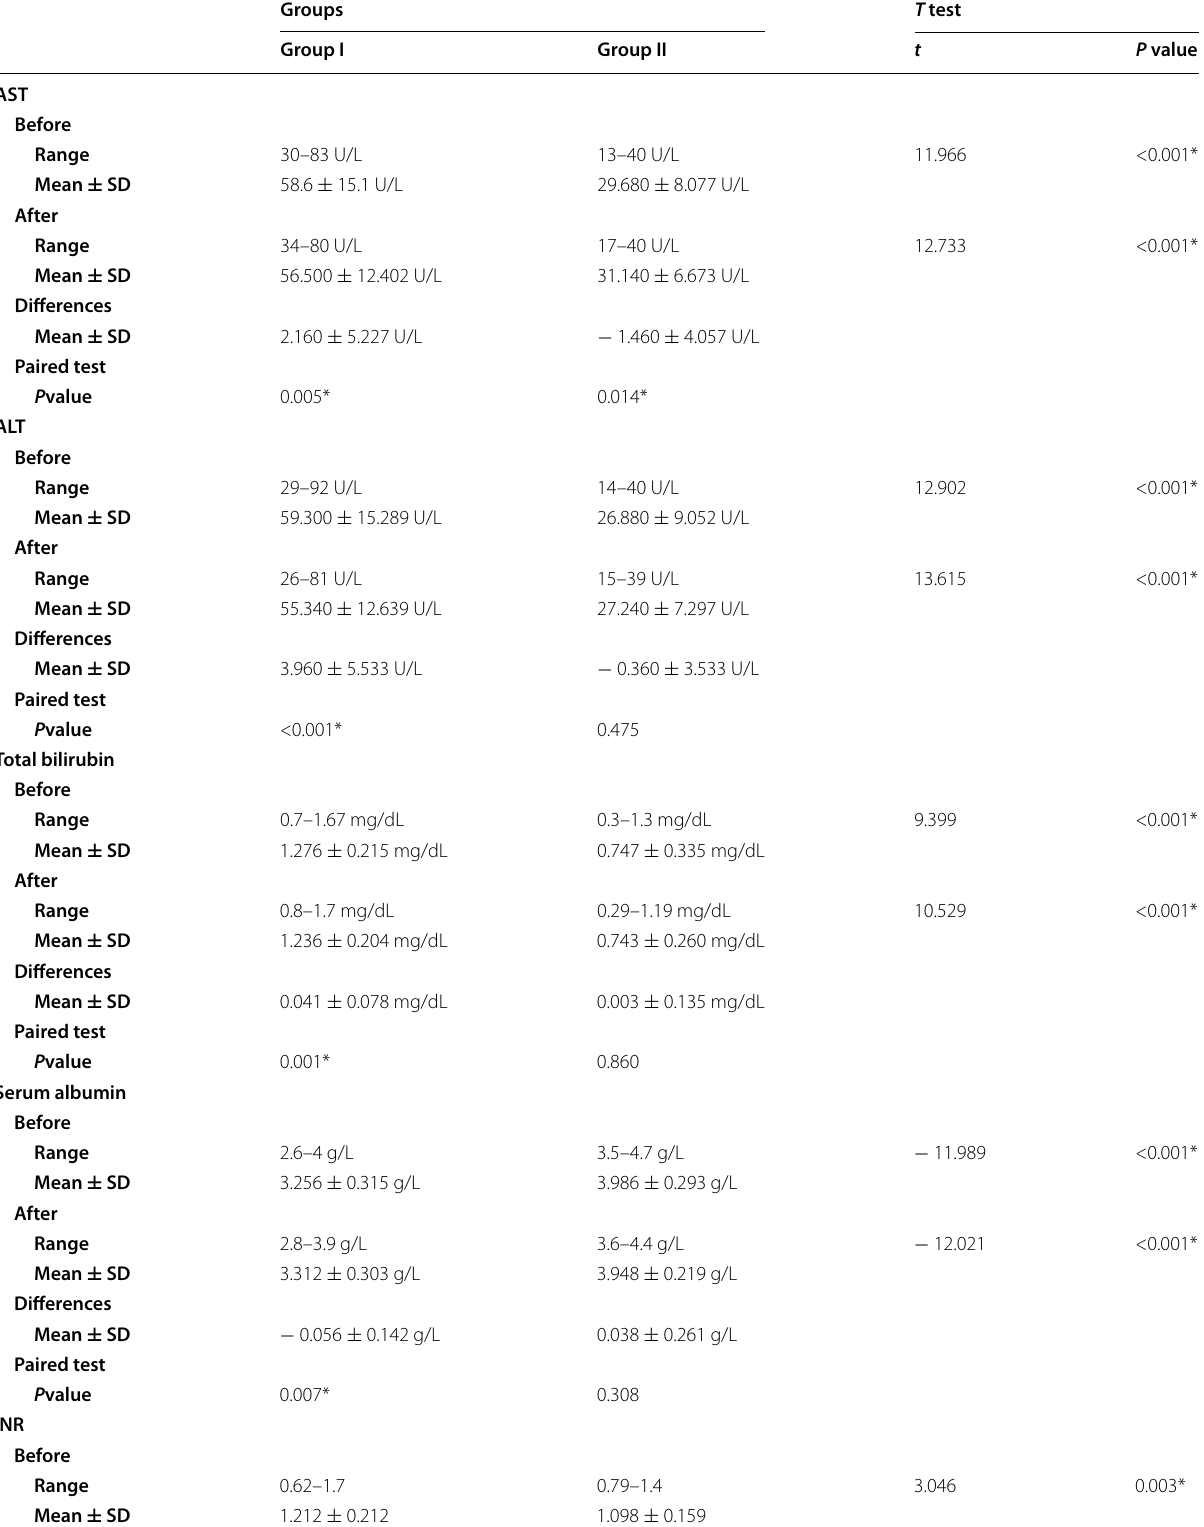
Table 2 Comparison between each group before and after treatment and the two studied groups according to liver profile Groups T test Group I Group II t P